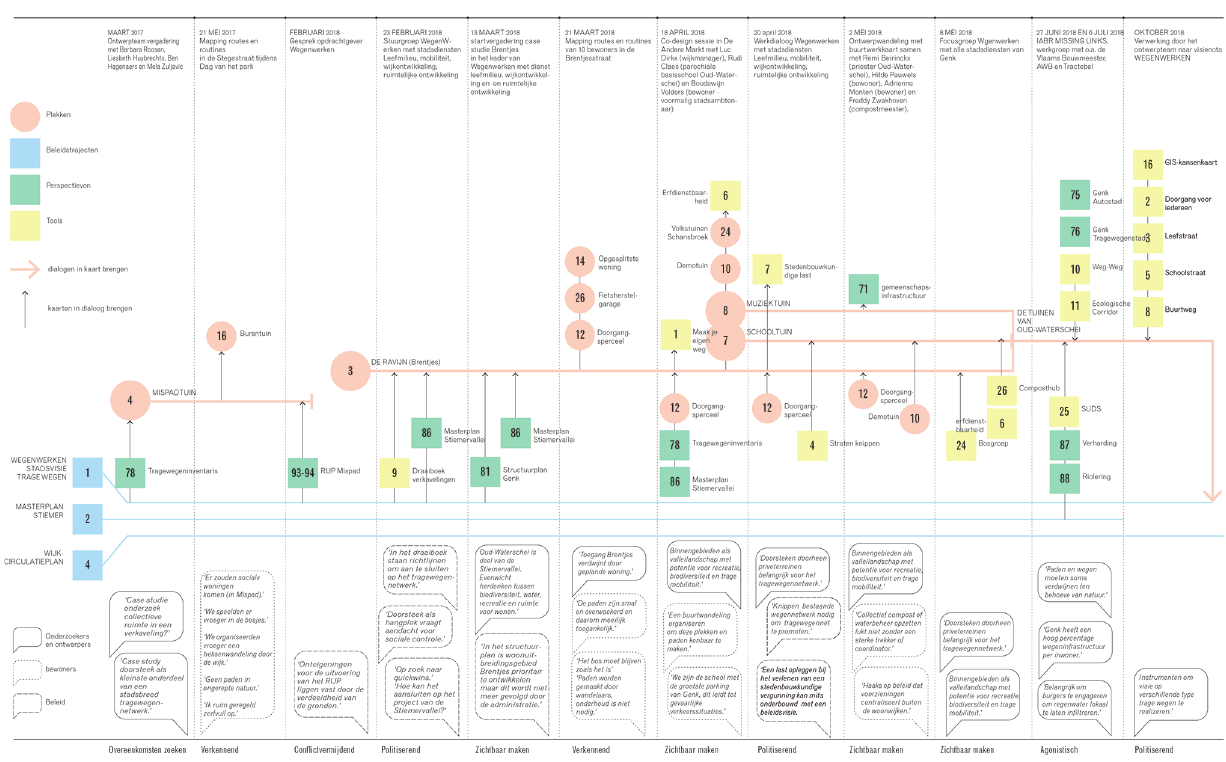
Figure 5. Timeline of the atlas-making. Source: Barbara